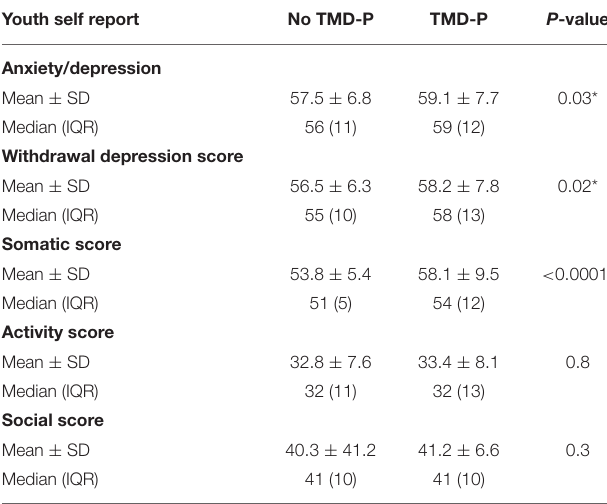
TABLE 2 | Self-reported psychosocial scores according to the Youth Self Report (YSR) among children and adolescents living in Jeddah, Saudi Arabia grouped according to the presence of self-reported temporomandibular disorder pain